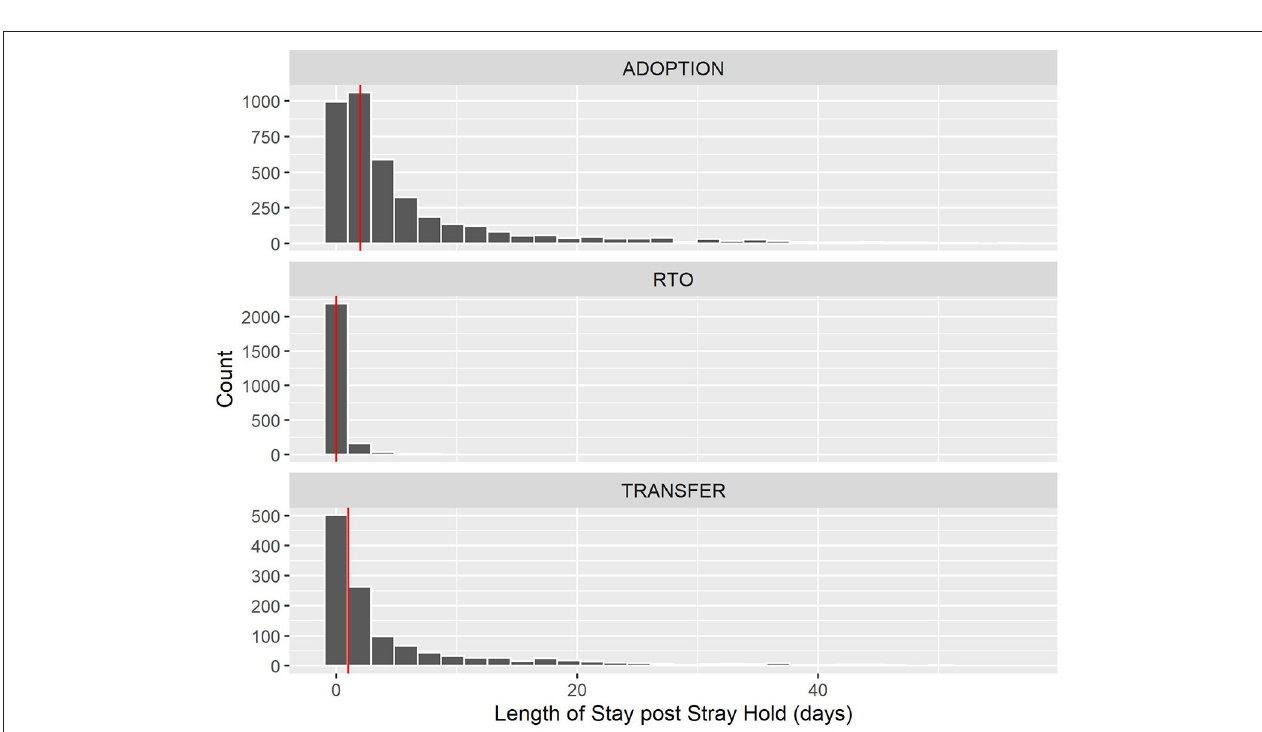
FIGURE 6 | Length of stay after hold period for healthy, adult stray dogs who were adopted, RTOed, or transferred. The red vertical line indicates the median for that outcome type, also summarized in a table below.